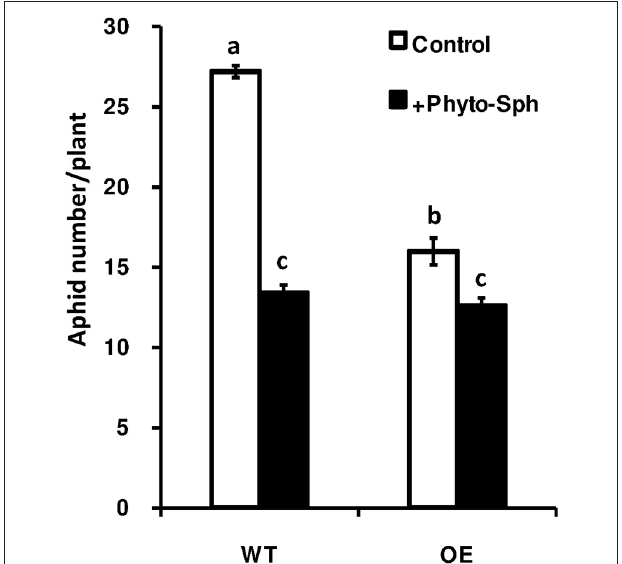
FIGURE 8 | Population density of the green peach aphid in phyto-sph treated WT and over-expressed Arabidopsis plants. Values represent means ± SE from five independent experiments. Different letters indicate significant differences among the treatments (two-factor ANOVA, P <